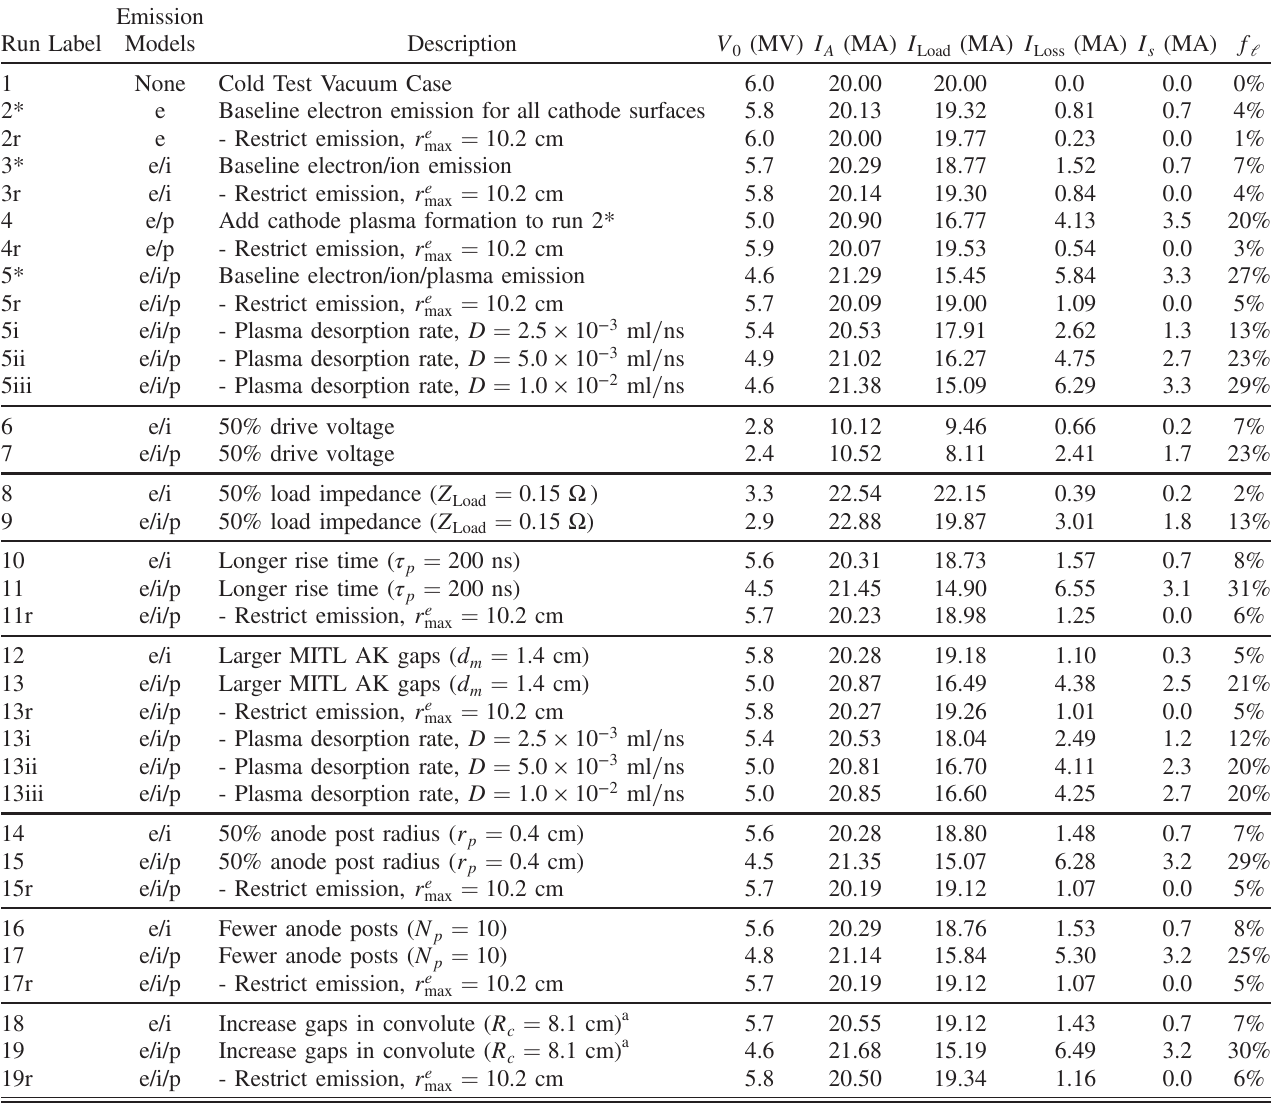
TABLE II. Summary of simulation results. The run labels with a “ * ” are baseline cases described in Sec. III. The letter “ r ” appended to a run label indicates the selected emission model has been restricted to a radius less than or equal to the stated value ( r e model labels are defined as follows; “ e ” refers to SCL electron emission from cathode surface locations with j E j ≥ 240 kV = cm, “ i ” refers to ion (H þ ) emission from anode surfaces that undergo a temperature increase of Δ T ≥ 400 K, and “ p ” refers to cathode plasma emission (H þ -electron) at a constant desorption rate D once local SCL electron emission